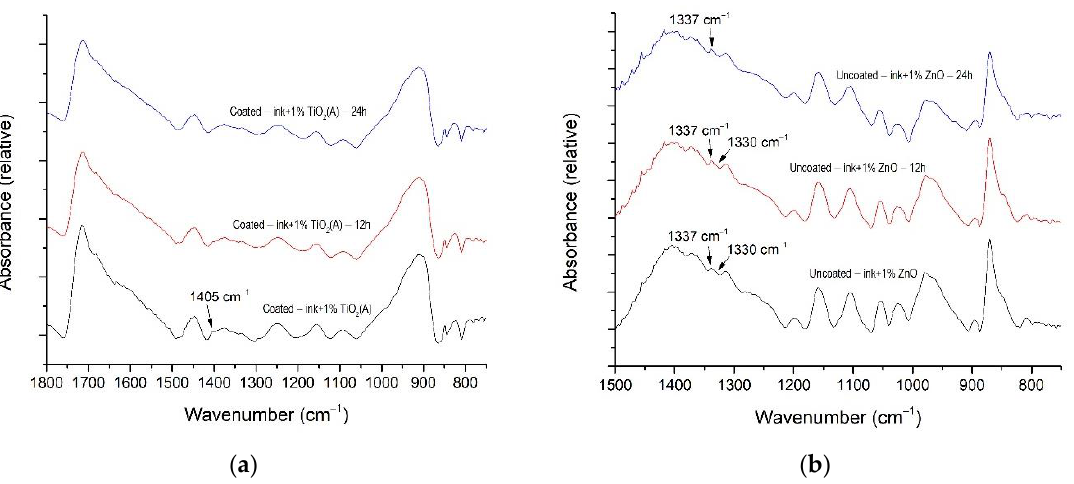
Figure 7. FTIR-ATR spectra of unmodified and modified ink films with addition of nanoparticles: ( a ) TiO 2 (A) on coated paperboard and ( b ) ZnO on uncoated paperboard.